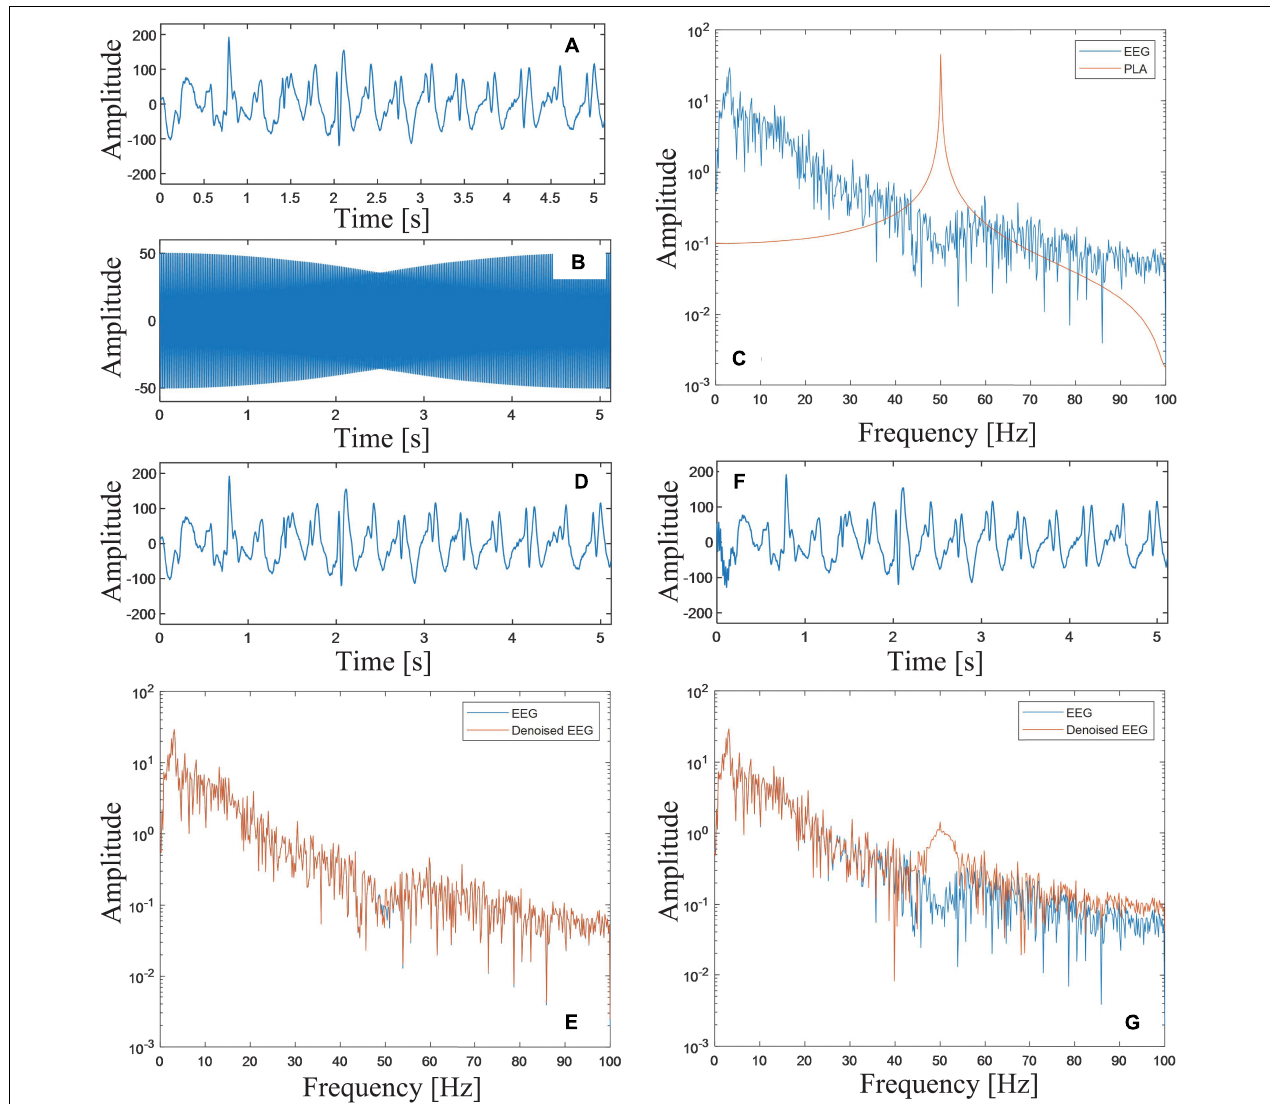
FIGURE 4 | (A) Time domain waveform of the EEG signal; (B) the simulated PLA noise; (C) FFT spectra of the EEG signal and the PLA noise; (D) the denoised signal based on the proposed DSCA; (E) FFT spectra of the EEG signal and the filtered signal using DSCA; (F) the denoised signal based on DNF method; and (G) FFT spectra of the EEG signal and the filtered signal using DNF